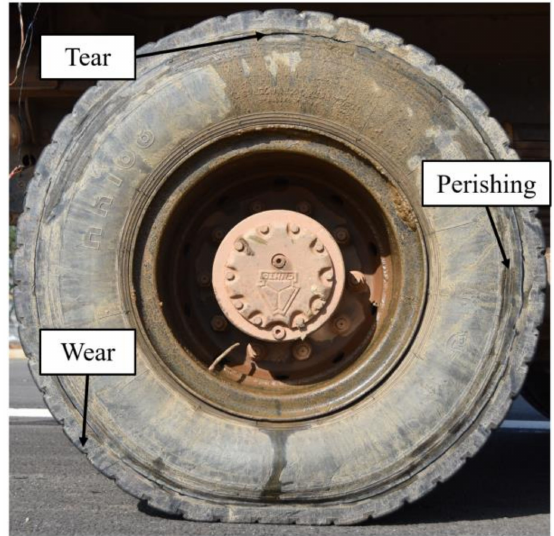
Figure 21. Wear, tear, and perishing of the